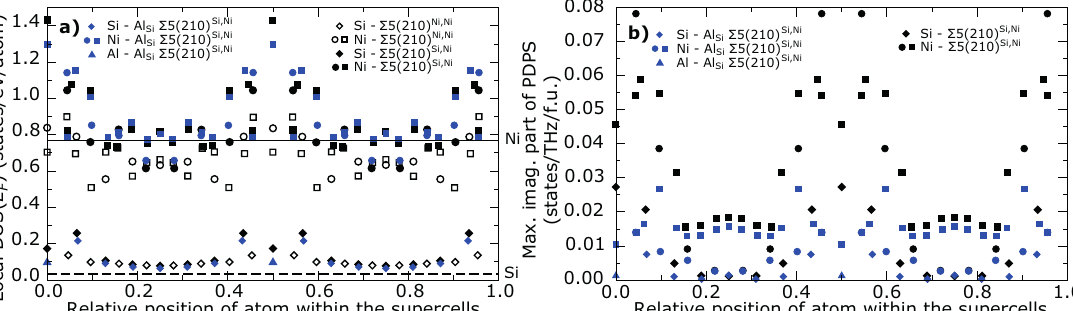
Figure 5. ( a ) Local density of states (DOS) at the Fermi level, E F , for each atom as a function z -coordinate in the supercell in all types of Σ 5(210) GB. Horizontal lines represents local DOS at the E F in bulk Ni 3 Si. ( b ) The highest partial density of phonon states (PDPS) in imaginary frequencies for each atom as a function of z -coordinate in the supercell in both Σ 5(210) Si,Ni GB with and without substituted Al atom. Squares represent Ni atoms in the layer occupied only by Ni atoms and circles represent Ni atoms in the layer occupied by Ni and Si